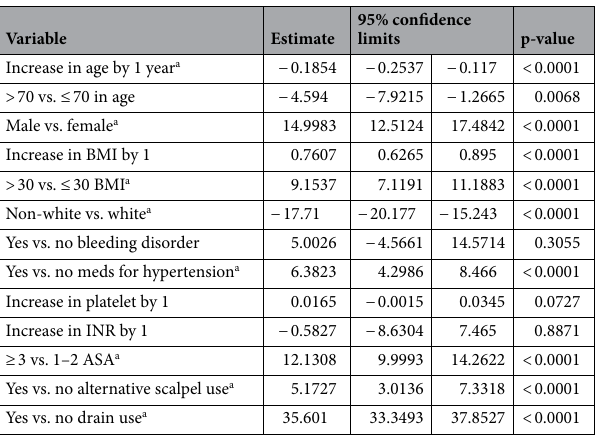
Table 5. Results of univariate analysis for factors affecting operative time. a Indicates variables carried forward to the multivariate analysis.